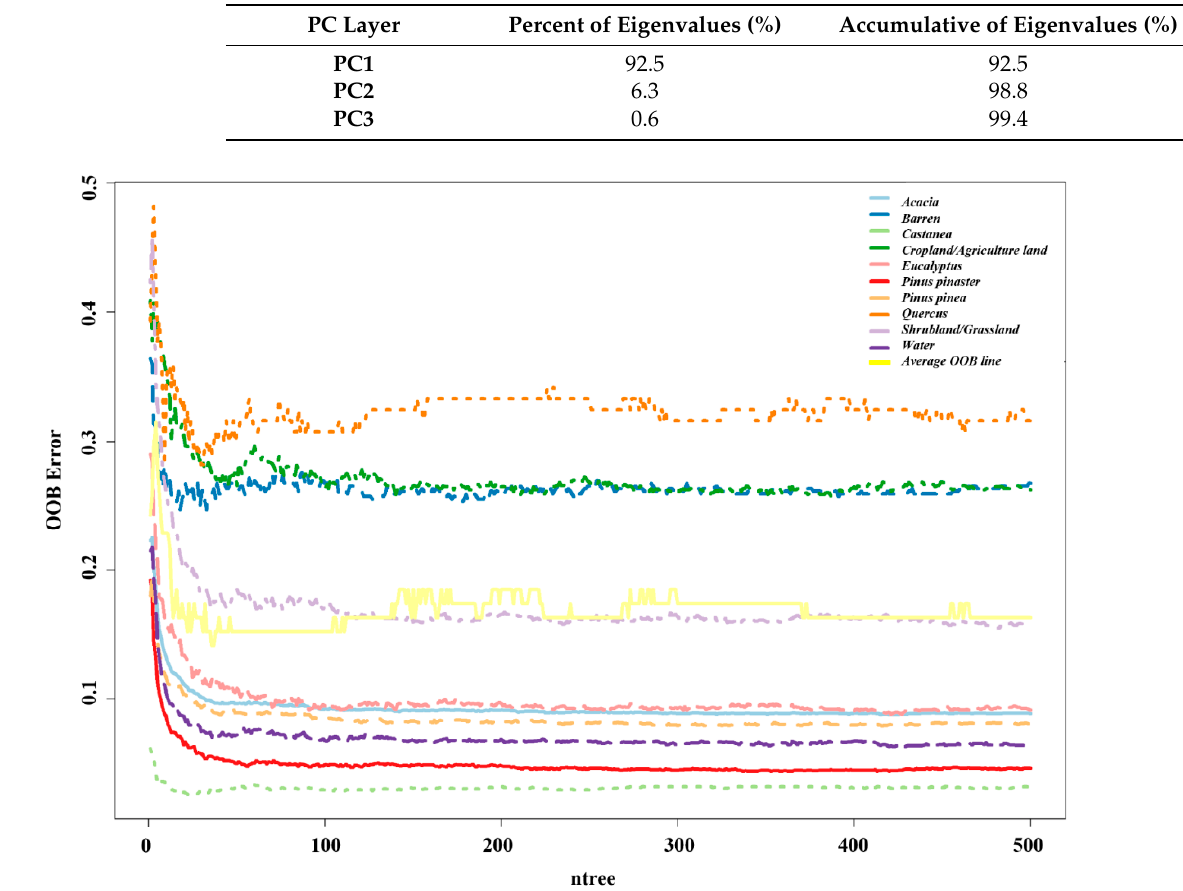
Figure A1. OOB Error of the number of RF mtry.